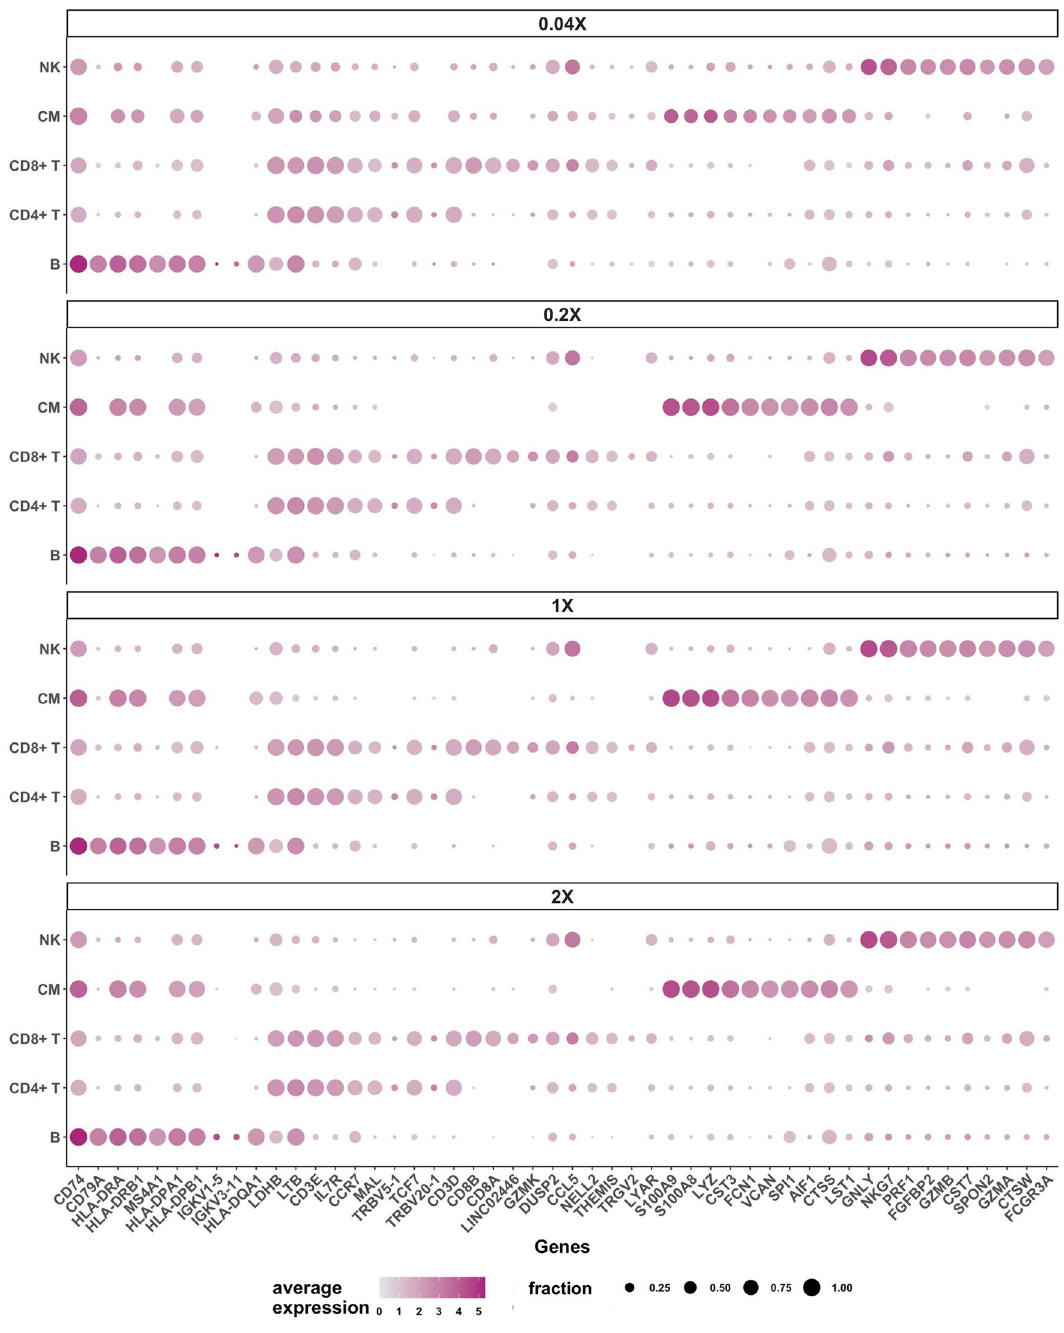
Figure 7. Top 10 genes of major cell types. Average expression values of the 10 most abundant differentially expressed genes (one versus all other comparison) in each of the major cell types at all antibody concentrations are displayed as dot plots. The centered log-ratio (CLR) normalized average gene expression is indicated by color intensity and the fraction of cells expressing an antigen is indicated by the size of the dots. The top 10 B cell antigens are shown on the left, followed by the top 10 CD4 T cell, CD8 T cell, classical monocyte (CM), and natural killer (NK) cell antigens (left to